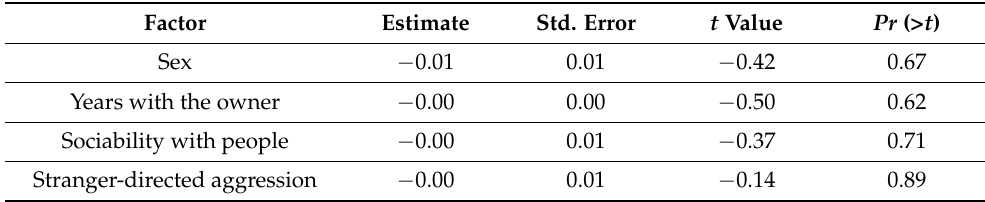
Table 1. Associations between nose length and sex, years with the owner, sociability with people, and stranger-directed aggression.